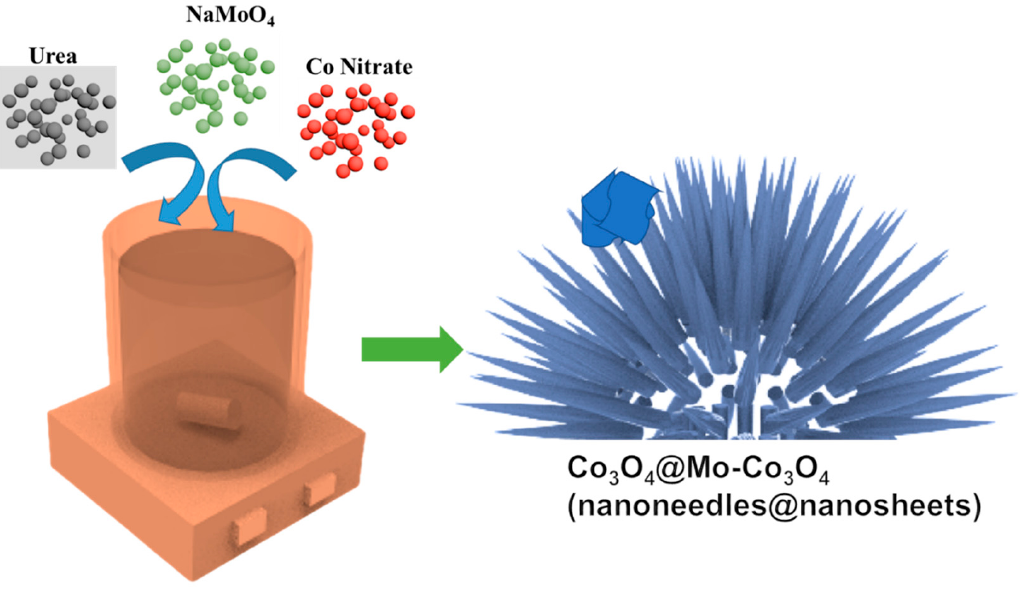
Figure 1. Schematic of Co 3 O 4 @Mo-Co 3 O 4 needle-like nanosheets, synthesized by hydrothermal method.